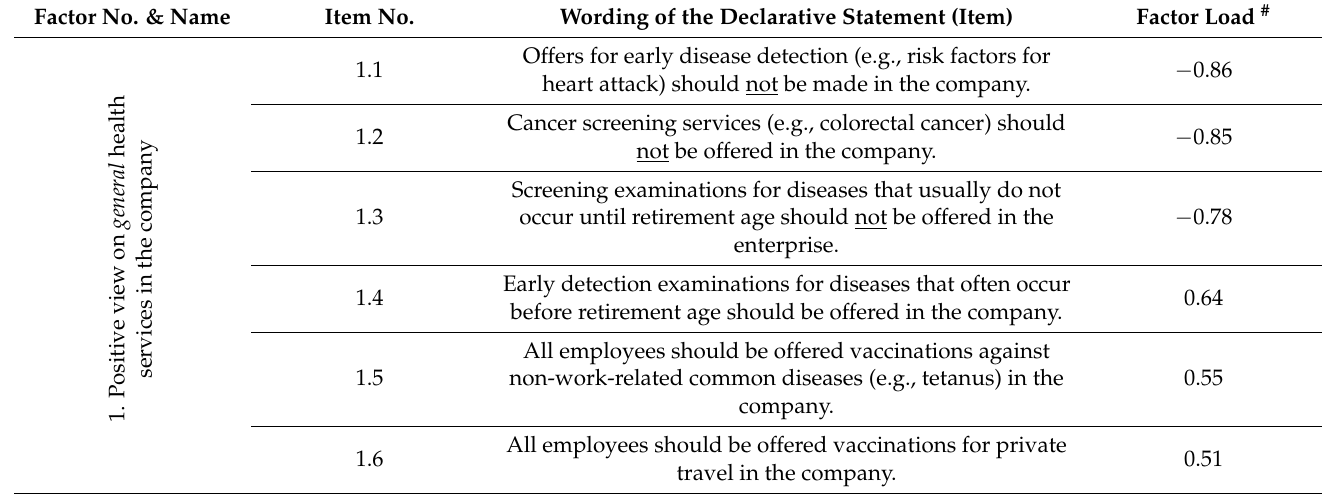
Table 4. Assignment of individual items to underlying factors